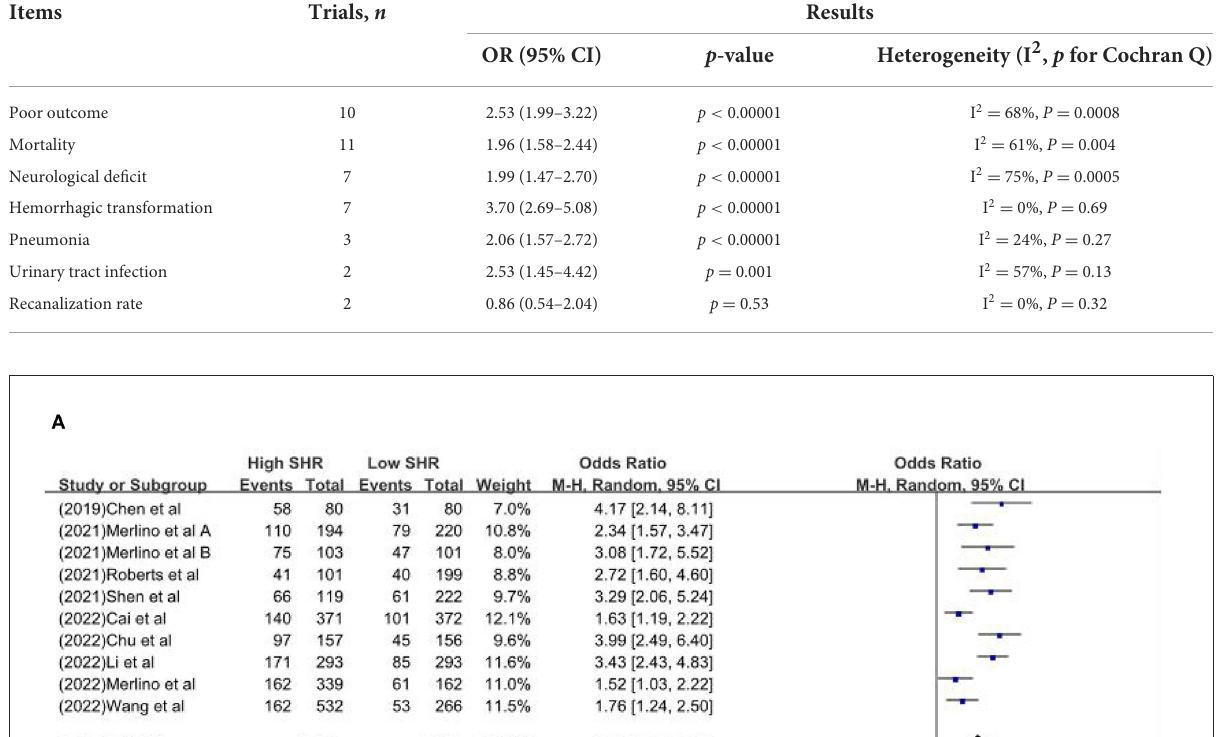
TABLE 2 Heterogeneity and meta-analysis of included studies.